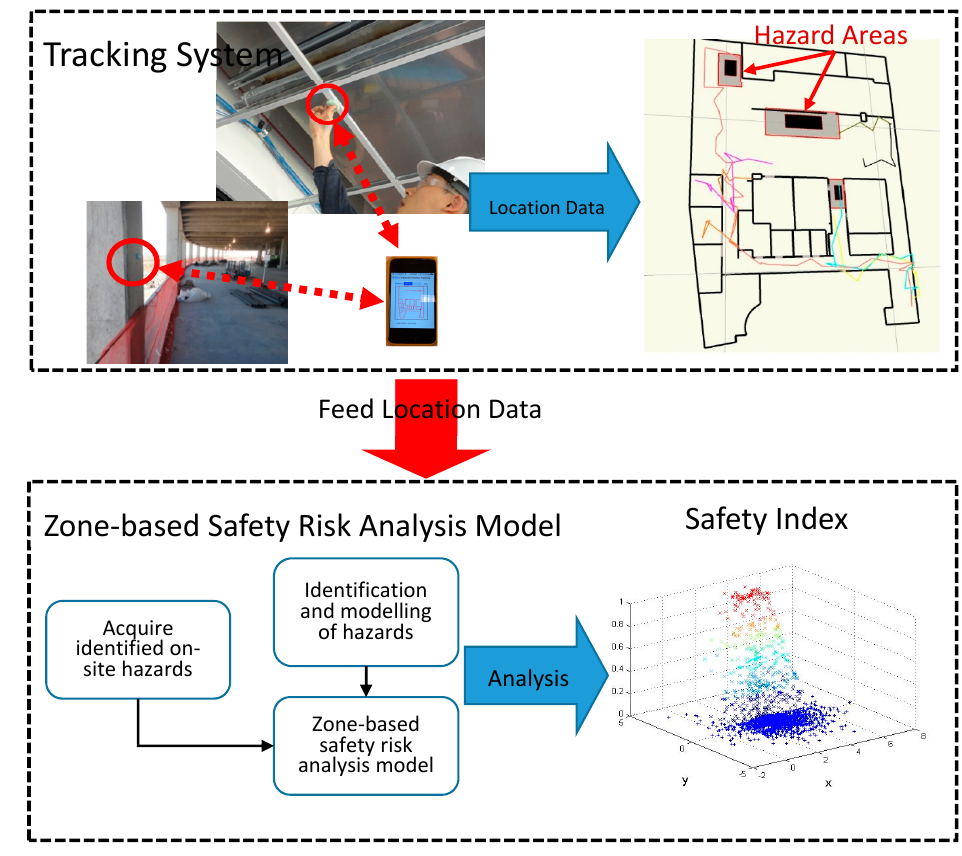
Figure 1. Flowchart of the automated safety monitoring system developed in this study.